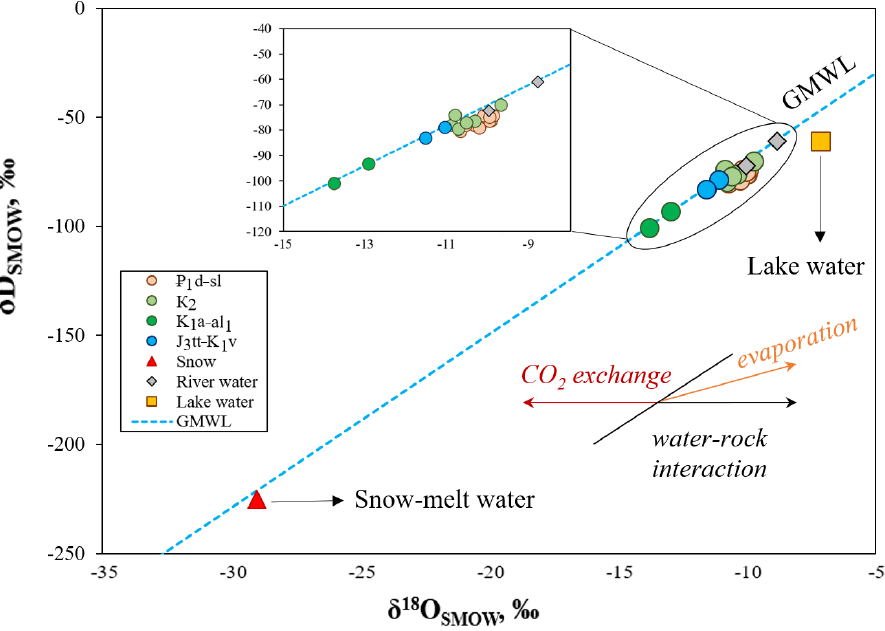
Figure 10. Binary distribution diagram of δ 18 O VSMOW and δD VSMOW in natural mineral water of the Essentuki field. Table 4. Isotopic characteristics of natural mineral water of the Essentuki field.